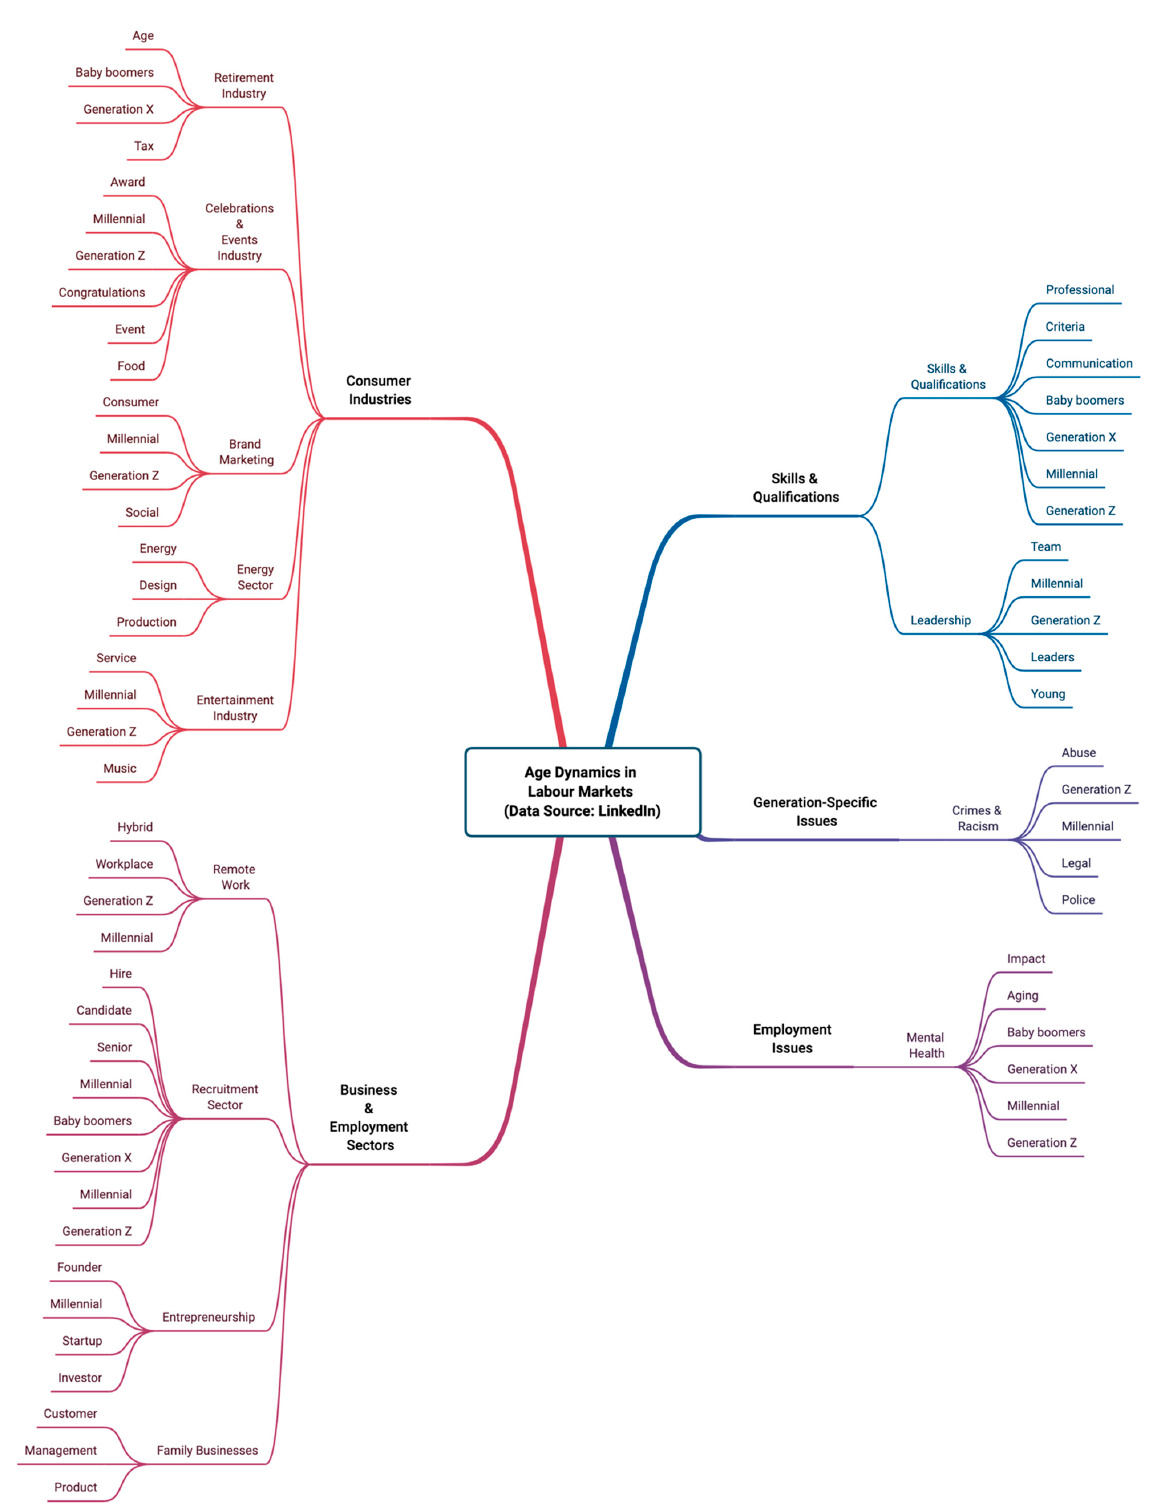
Figure 2. LinkedIn perspective taxonomy of the multi-generational labour market.